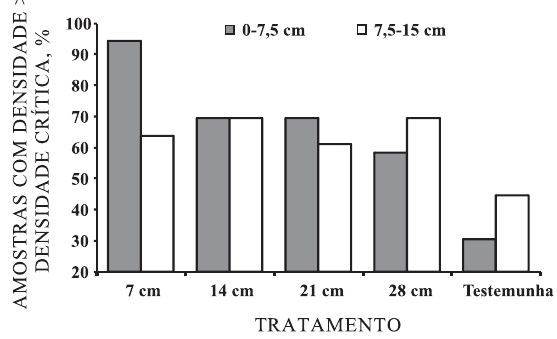
Figura 2. Percentagem das amostras com densida- de do solo maior do que a densidade do solo crí- tica. Nas camadas de 0–7,5 e 7,5–15 cm de pro- fundidade e nos tratamentos com 7, 14, 21 e 28 cm de altura de pastejo e testemunha sem